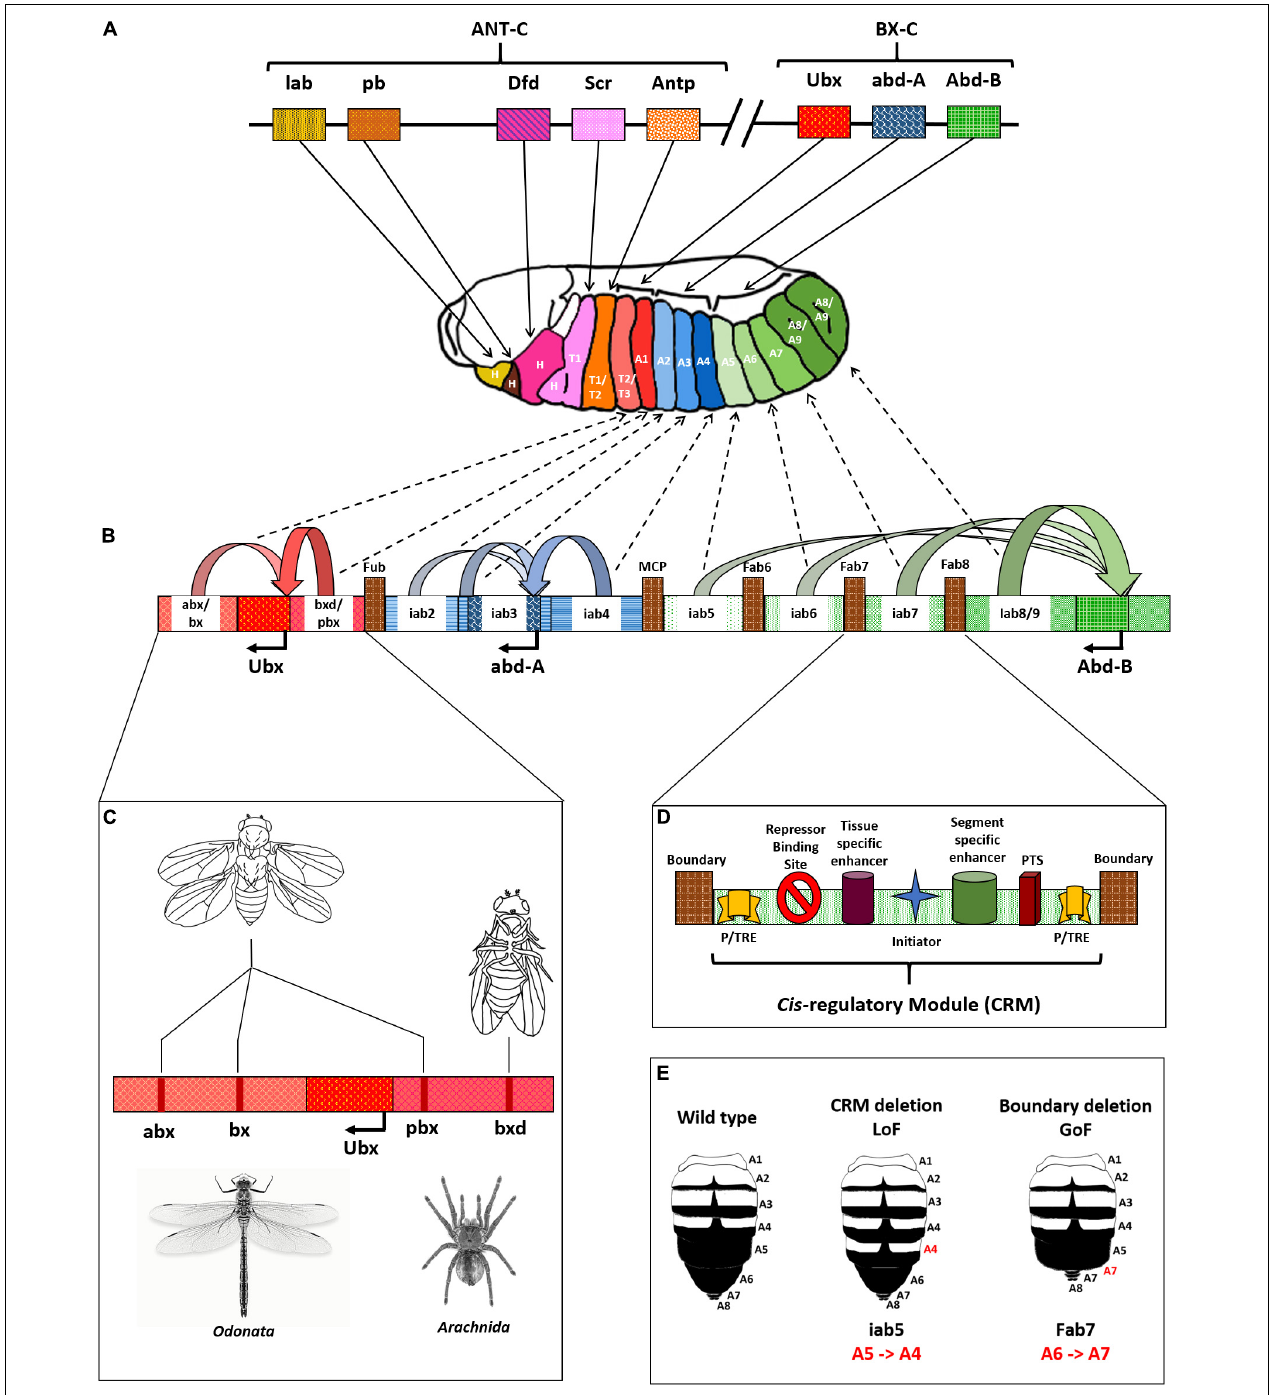
FIGURE 2 | Drosophila Hox complex and regulation of BX-C. (A) Drosophila Hox genes are split into two complexes, Antennapedia complex (ANT-C), and bithorax complex (BX-C), as shown. Each gene is responsible for providing identity to a specific segment, as indicated by bold arrows. (B) Cis -regulatory modules (CRMs) of the BX-C cause differential expression of Hox genes in a segment-specific manner. The genes influenced by their CRMs are shown as curved arrows with respective colors, and the dotted arrows indicate the segments they influence. (C) Representation of cis -regulatory module with different elements including boundary/insulator, Polycomb/Trithorax Response Elements (P/TRE), and promoter tethering sequences (PTS). (D) Deletion mutations in CRMs of Ubx leading to phenotypes that look similar to an odonate, like dragonfly or an arachnid, like spider. (E) Loss and gain of function mutations in the abdominal region of Drosophila due to deletions of CRMs or